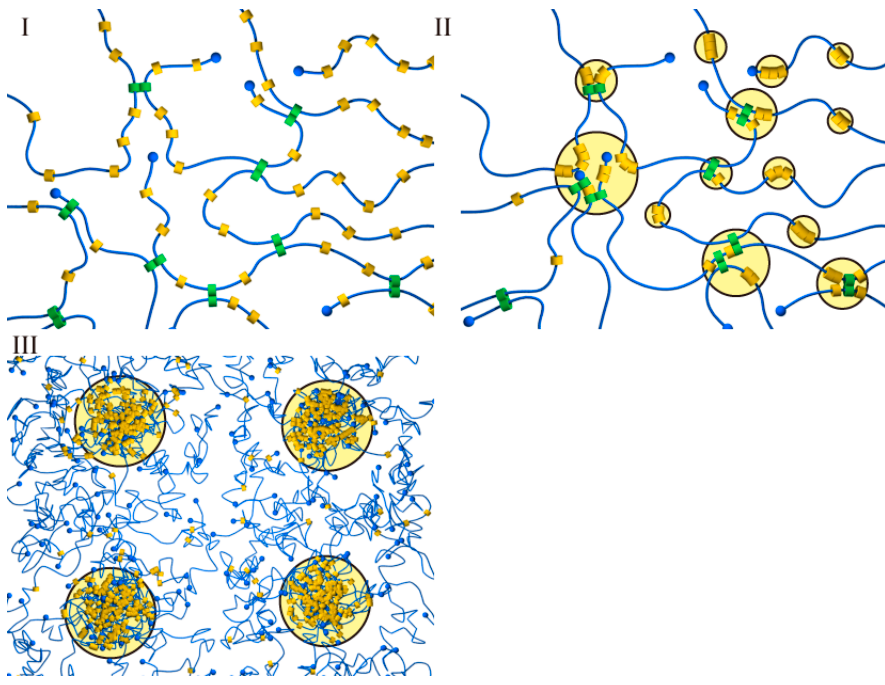
Figure 14. Schematic illustrations of the mesoscale structure of carboxylated SR gels in acetone/water mixtures. In the region I, polymer chains and CDs are distributed sparsely. As the acetone fraction increases, the carboxylated CD in the SR gels should lose the charge and form aggregation, and chains slide to swollen domain in region II. The aggregated and swollen domains are more clearly separated like a micro phase separation, yielding a peak in SAXS pattern in region III.